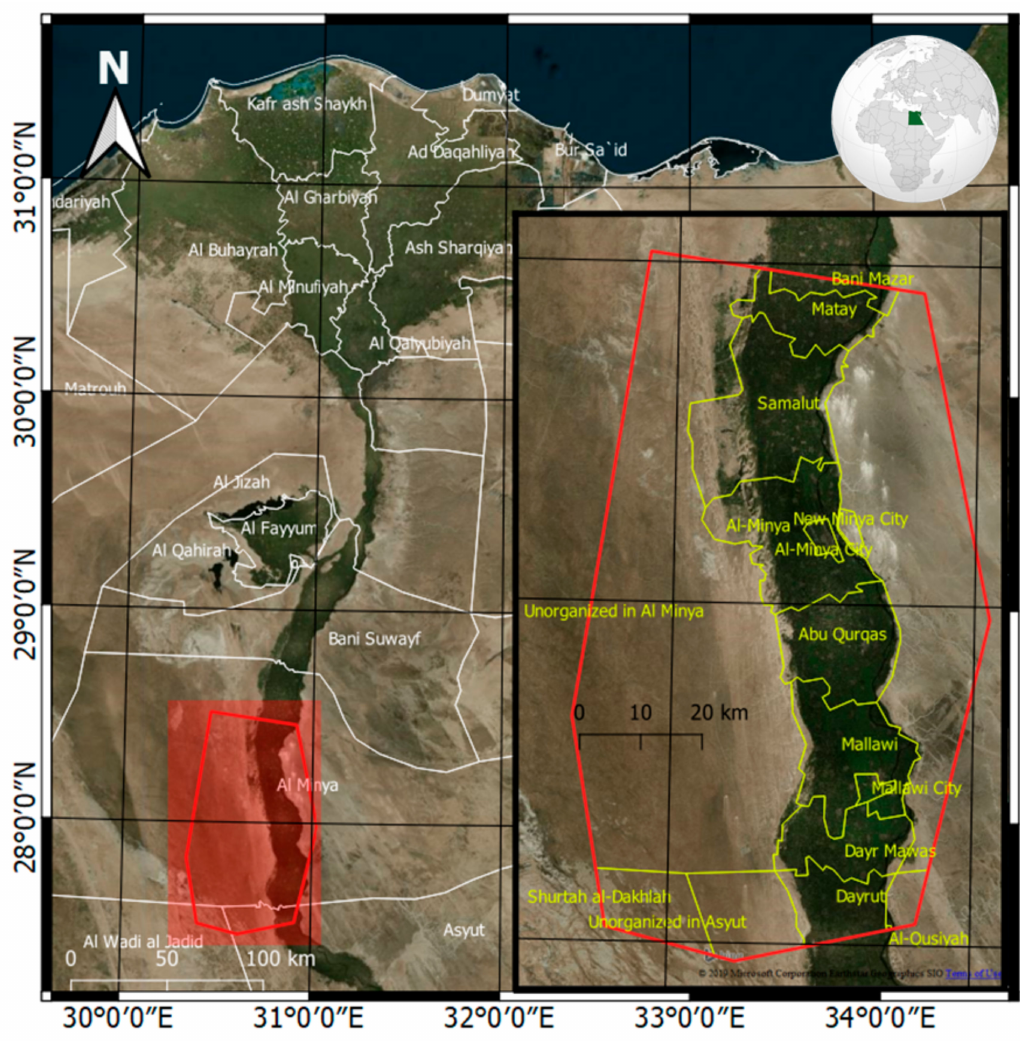
Figure 4. Google Earth image overlaid with the Egyptian administrative boundaries of its governorates (left), and zoom over the location of our study area with the district boundaries